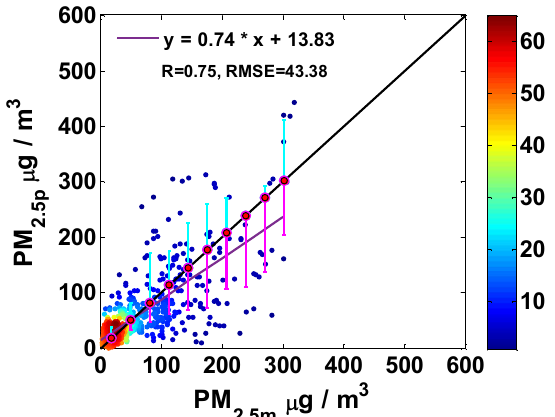
Figure 15. Validation result of satellite application with SPSEMCA of the Beijing area in 2016. The color bar from 0 to 60 represents the sample density. The blue-green error bars represent the mean RMSE for samples with estimated PM 2.5 that are larger than the measured value (samples above the 1:1 line); the magenta error bars represent the mean RMSE for samples with estimated PM 2.5 lower than the measured value (samples under the 1:1 line); the magenta points on the 1:1 line represent group centers.